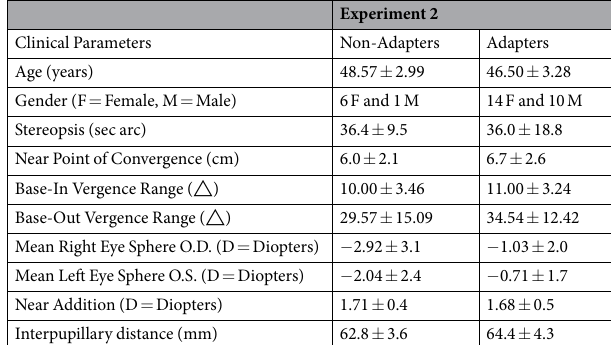
Table 2. Mean and Standard Deviation of Non-Adapters and Adapters to PALs Group Attributes for Experiment 2 Phoria Adaptation Experiment studying incipient presbyopes who were fitted for PALs for the first time.